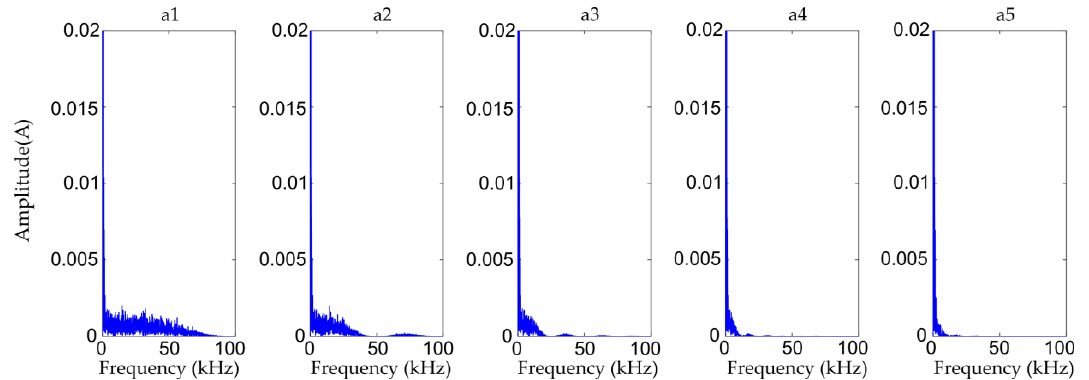
Figure 4. Spectral analysis of detailed signals.